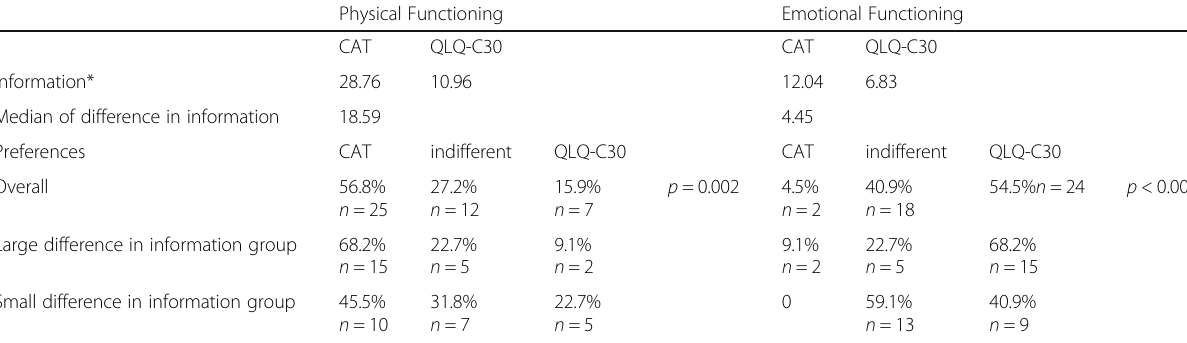
Table 3 Appropriateness rating CAT vs. QLQ-C30